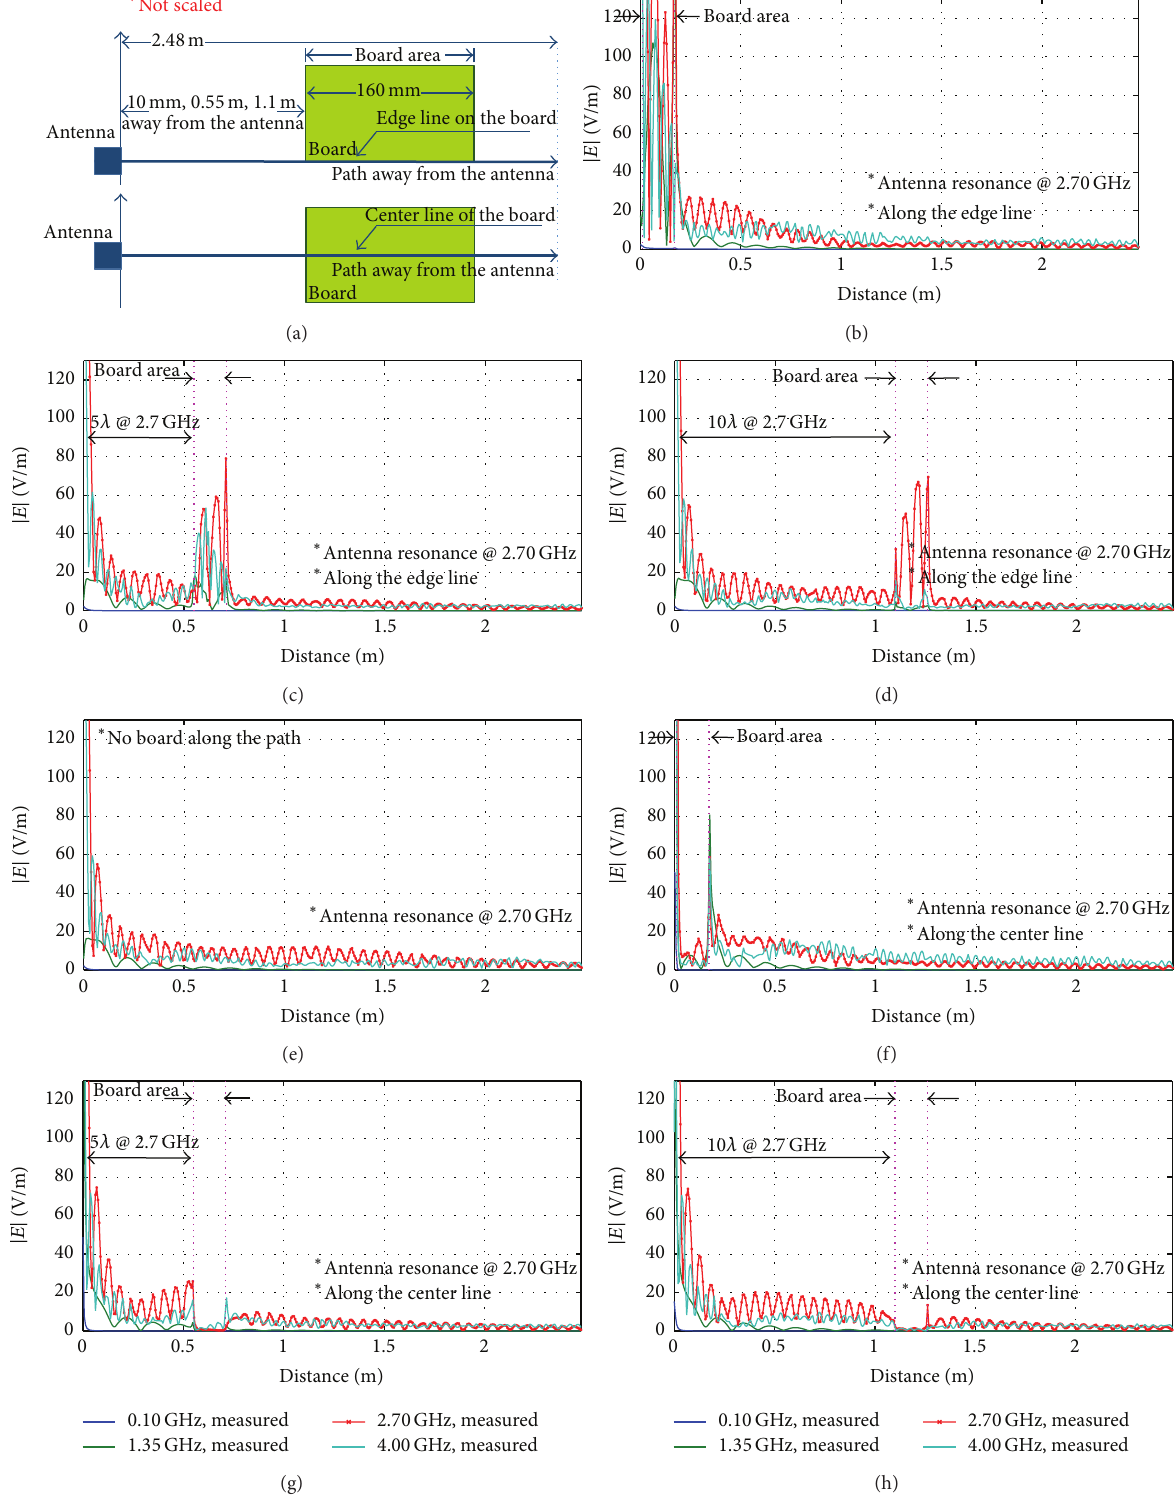
Figure 10: (a) Two paths away from antenna: one path is along the edge of the board and the other one is along the center line of the board. | E | -field distributions (e) without board along the path, (b) with board at 10mm away from antenna (near field) along the edge of board, (c) with board at 5 𝜆 (0.55 m, near field) away from antenna along the edge of board, (d) with board at 10 𝜆 (1.1m, far field) away from antenna along the edge of board, (f) with board at 10 mm away from antenna (near field) along the center line of board, (g) with board 5 𝜆 (0.55 m, near field) away from antenna along the center line of board, and (h) with board at 10 𝜆 (1.1m, far field) away from antenna along the center line of